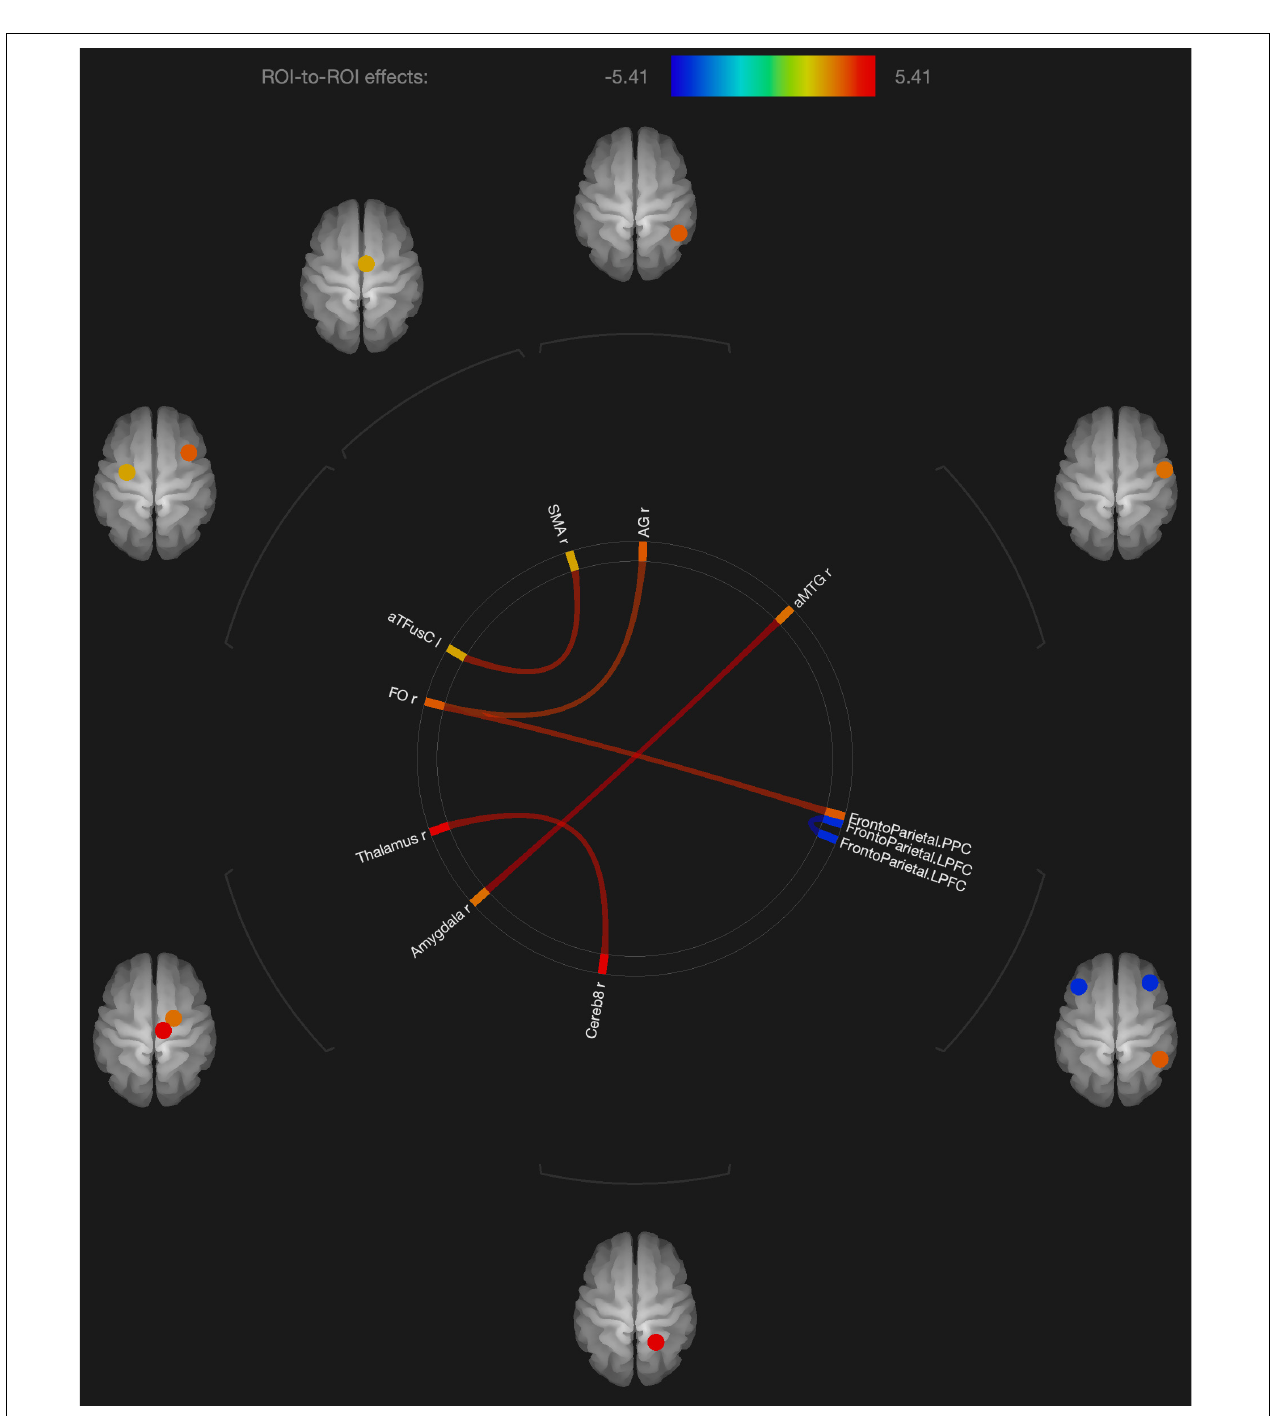
FIGURE 2 | Visualization of ROI-to-ROI connections comparing orgasmic meditation (OM) and neutral groups among females, p -FDR corrected < 0.05.